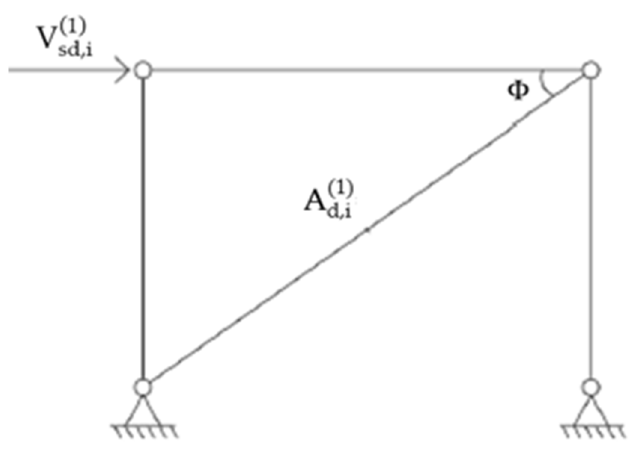
Figure 6. Calculation scheme of step 1.